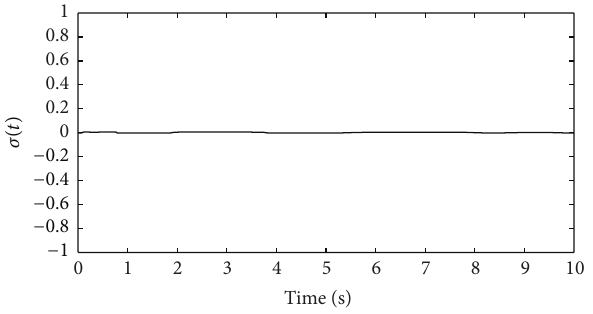
Figure 3: The time response of switching surface 𝜎(𝑡)